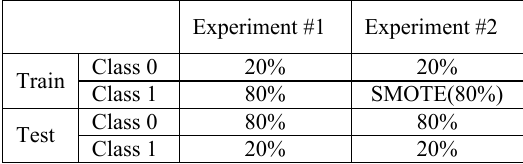
Table 5 Cross validation configuration of the two experiments